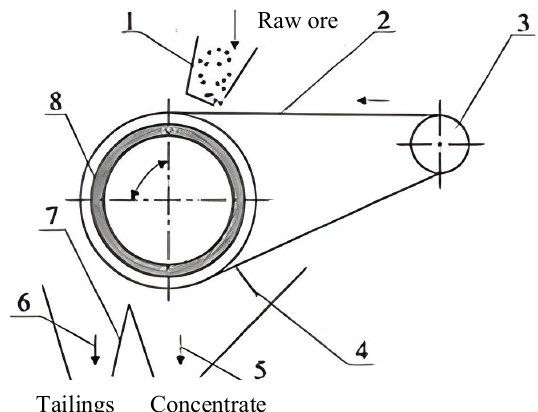
Figure 8. Separation principle of CTFG dry magnetic separator for fine ore [41] 1—vibration feeder; 2—ultra-thin transport belt; 3—tail wheel; 4—concentrate scraper; 5—concentrate bucket; 6—tailings bucket; 7—ore plate; 8—rotating magnetic system.